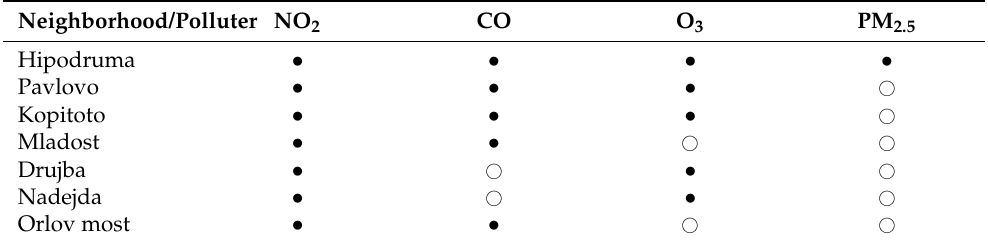
Table 1. Availability of polluters regarding districts of and near Sofia City. The available measure- ments are marked with black circles.